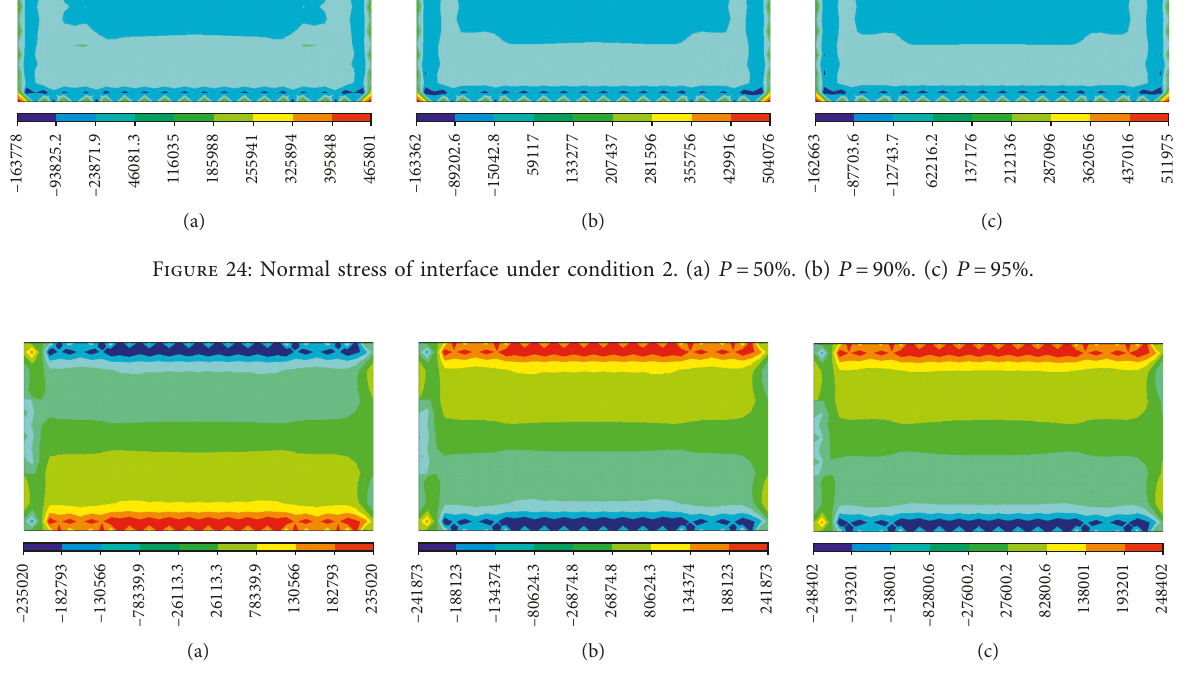
50%. (b) P 90%. (c) P 95%. (cid:31) (cid:31) (cid:31)